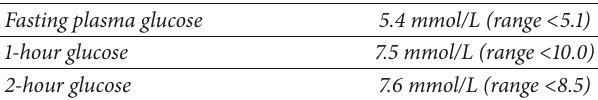
Table 3: Oral glucose tolerance test.